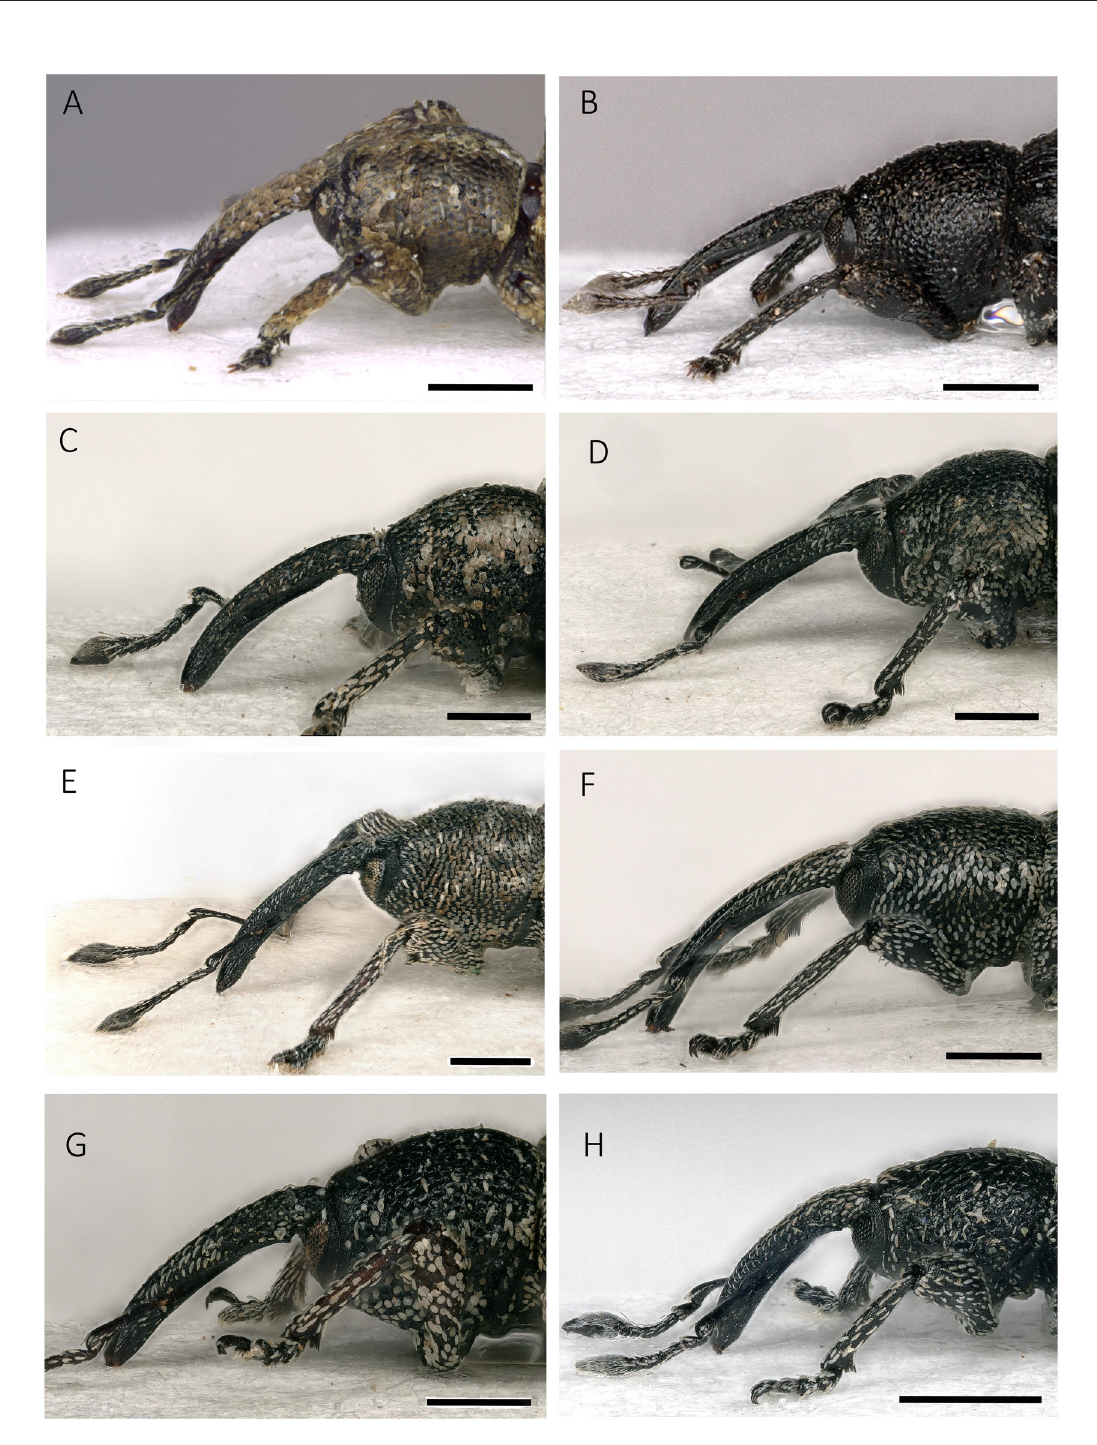
Fig. 3. Head and prothorax in lateral view of species of Smicronyx from southern Africa (Part 1). A . Sharpia madibai sp. nov., ♂, holotype (SAMC). B . Afrosmicronyx cycnii sp. nov., ♂, holotype (SAMC). C . Afrosmicronyx louwi sp. nov., ♂, holotype (SAMC). D . Afrosmicronyx marshalli sp. nov., ♂, holotype (SANC). E . Afrosmicronyx nebulosipennis , sp. nov., ♂, holotype (BMNH). F . Smicronyx gracilipes sp. nov., ♀, holotype (SAMC). G . Smicronyx similis sp. nov., ♂, holotype (SANC). H . Smicronyx pseudocoecus sp. nov., ♂, holotype (SAMC). Scale bars: 0.5